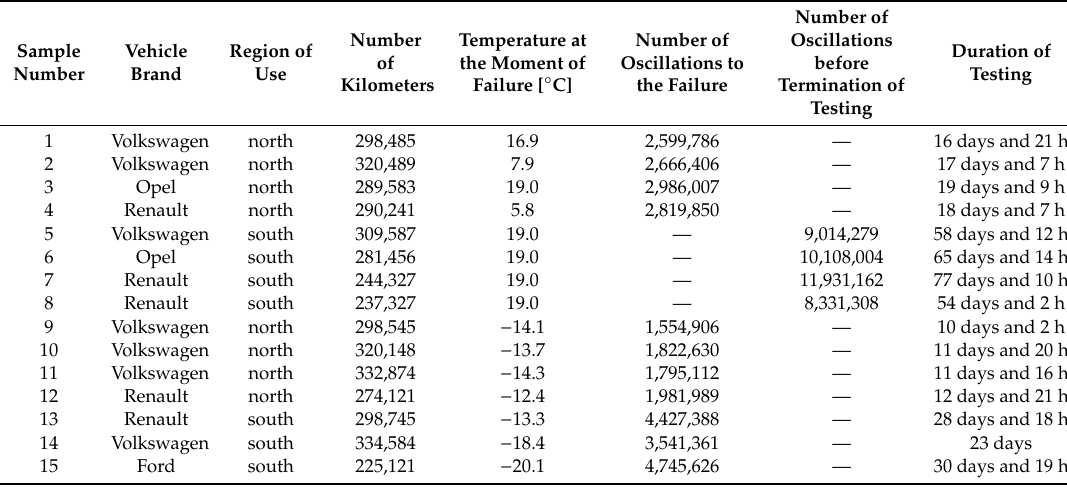
Table 7. The test results for the cu ff s from both